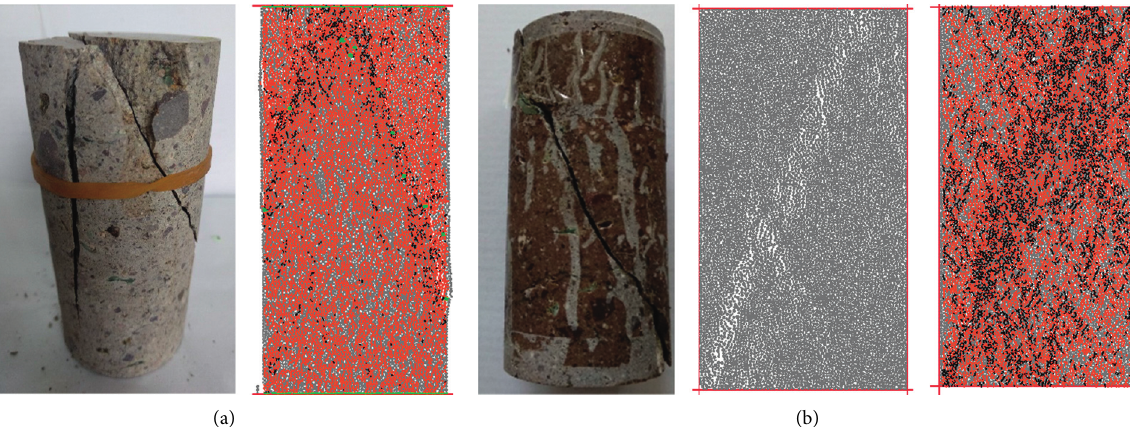
Figure 7: Failure mode. (a) Uniaxial compression test. (b) Confining compression test under the confining pressure 15MPa (the red line is the bonded tensile crack, and the black line is the bonded shear